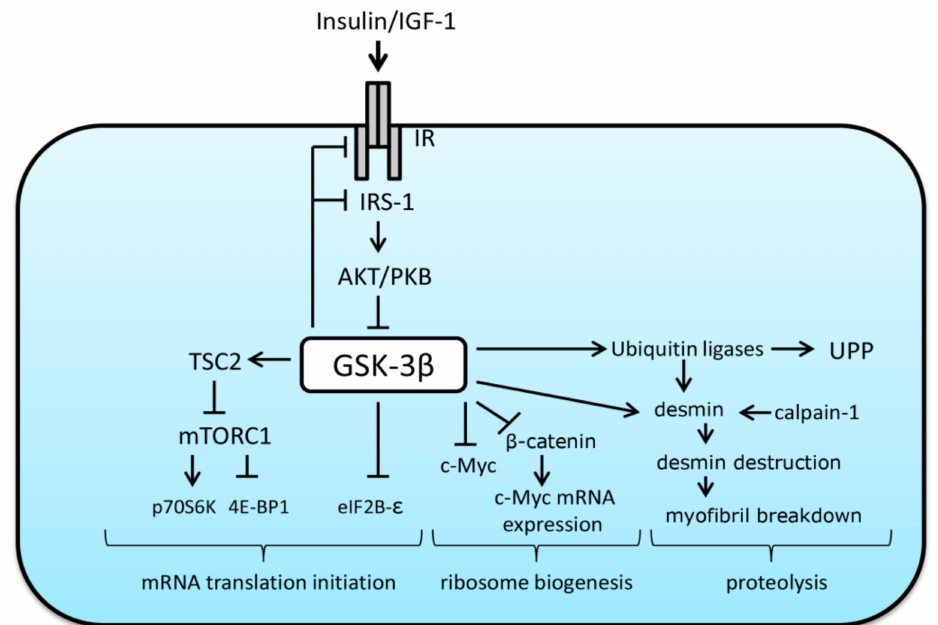
Figure 2. Involvement of GSK-3 β in the regulation of anabolic and catabolic signaling pathways. Please see description in the text above. Arrows indicate stimulatory signals, whereas T bars represent inhibitory signals. IGF-1—insulin-like growth factor-1, IR—insulin/insulin-like growth factor receptor, IRS-1—insulin receptor substrate-1, PKB—protein kinase B, UPP—ubiquitin-proteasome pathway, TSC2—tuberous sclerosis complex 2, mTORC1—mammalian/mechanistic target of rapamycin complex 1, p70S6K—ribosomal protein S6 kinase, 4E-BP1—eukaryotic initiation factor 4E binding protein, eIF2B- ε —epsilon subunit of the eukaryotic initiation factor 2B, c-Myc—c-myelocytomatosis oncogene (transcription